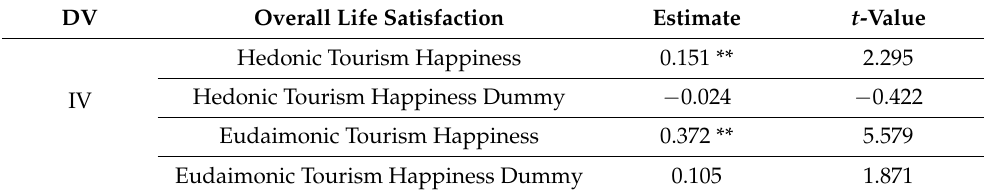
Table 8. Results of Asymmetry